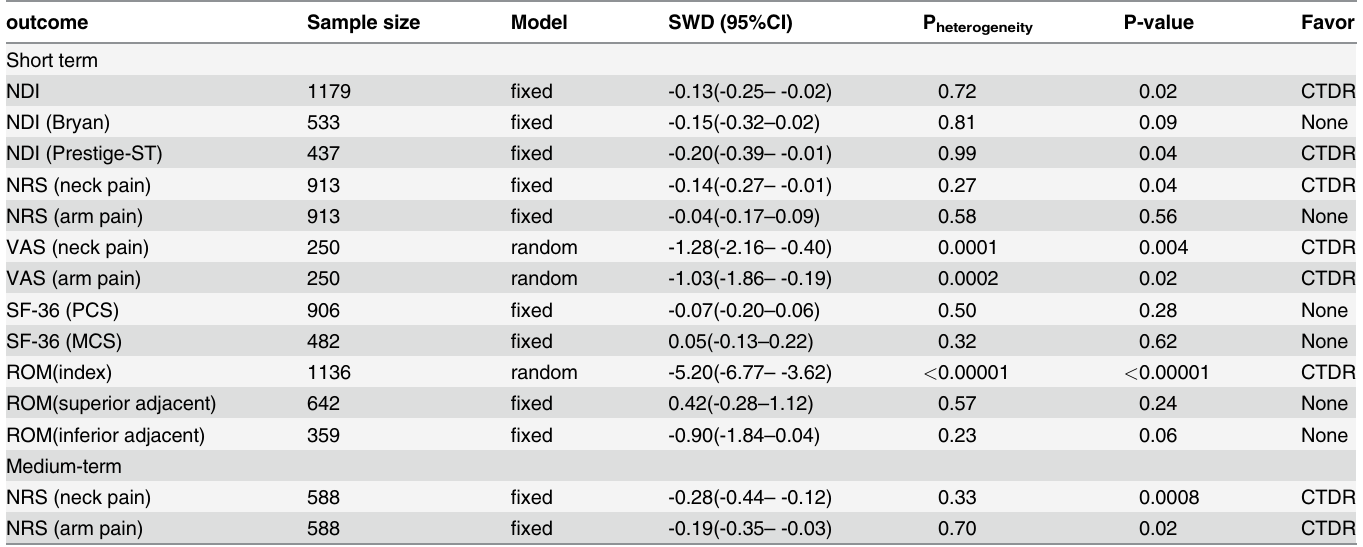
Table 5. The pooled results of meta-analysis.